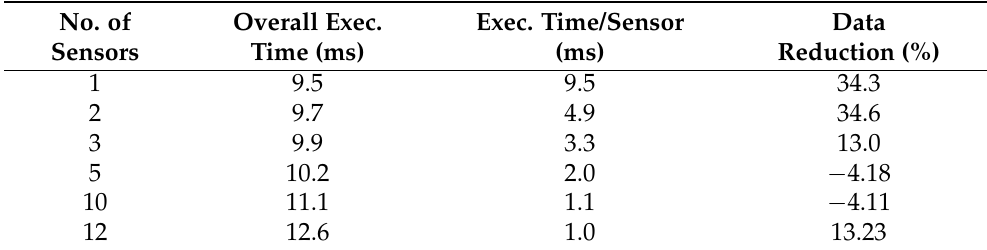
Table 2. Execution times (FFT + frequency filtering + noise addition) and data reduction ( f c = 100, σ = 5).